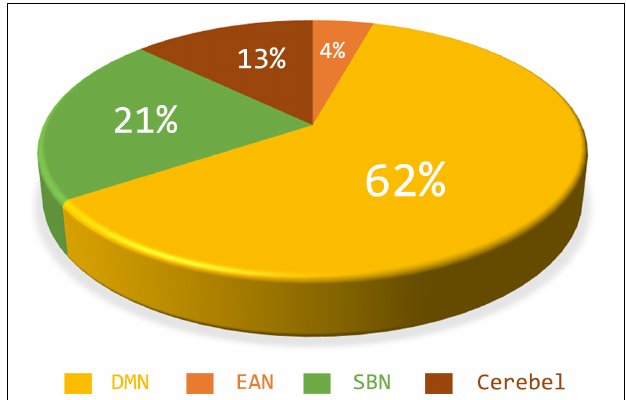
FIGURE 8 | The feature contribution rate of different sub-networks to classifier